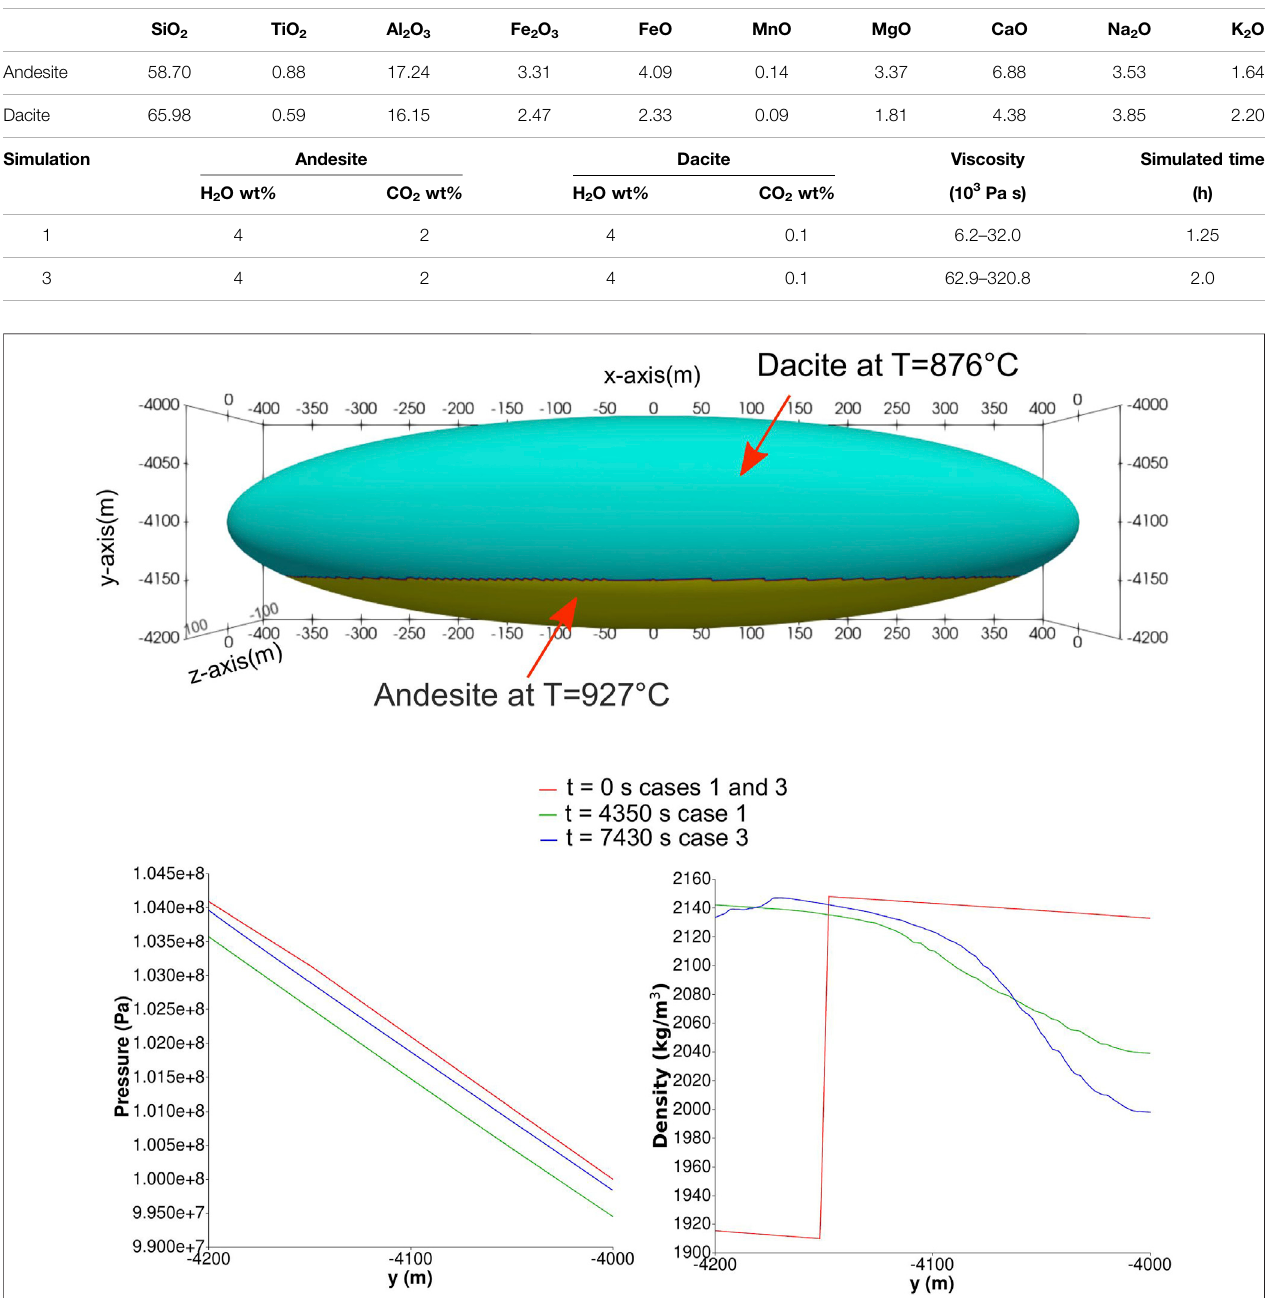
TABLE 1 | Composition of magmas and list of simulations. For consistency with the corresponding 2D cases in (Garg et al., 2019), we keep the same simulations numbering here. SiO 2 TiO 2